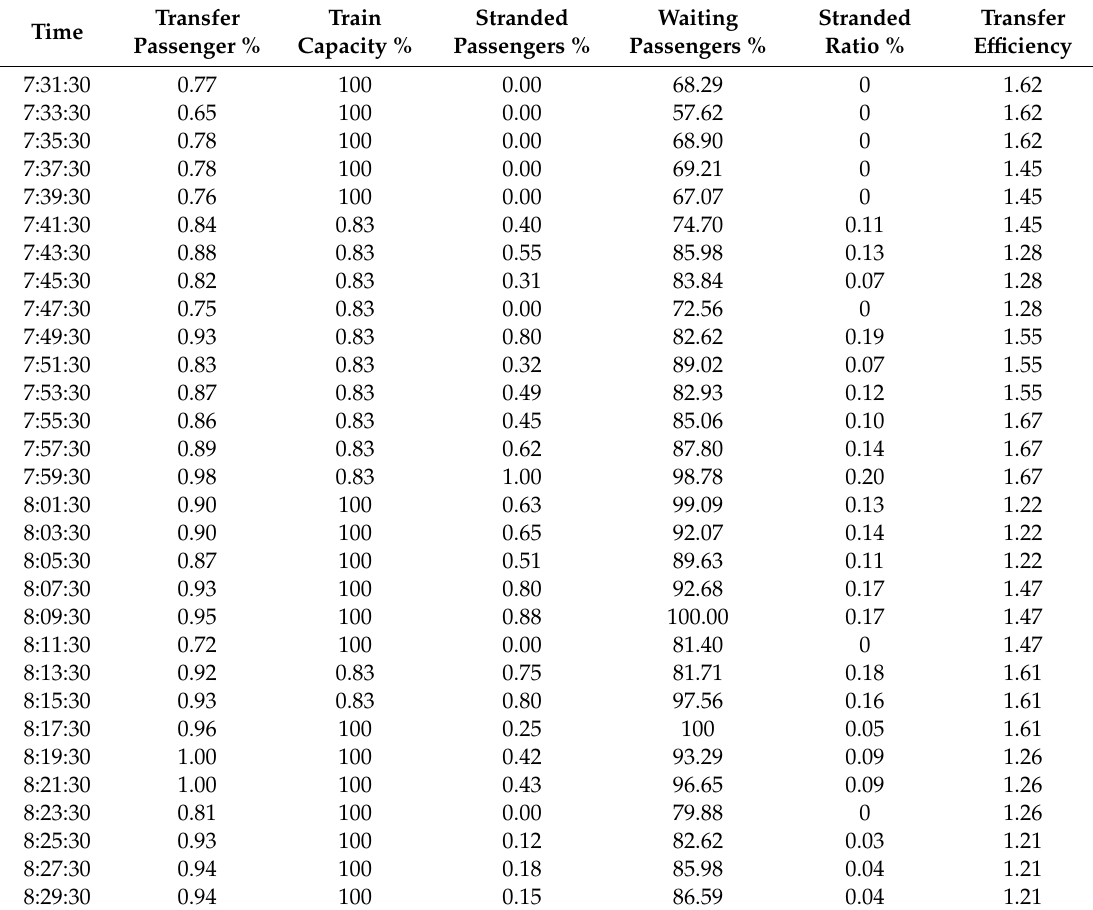
Table 2. Example of the calculated data in the station platform during peak time Lu and Han (2016).